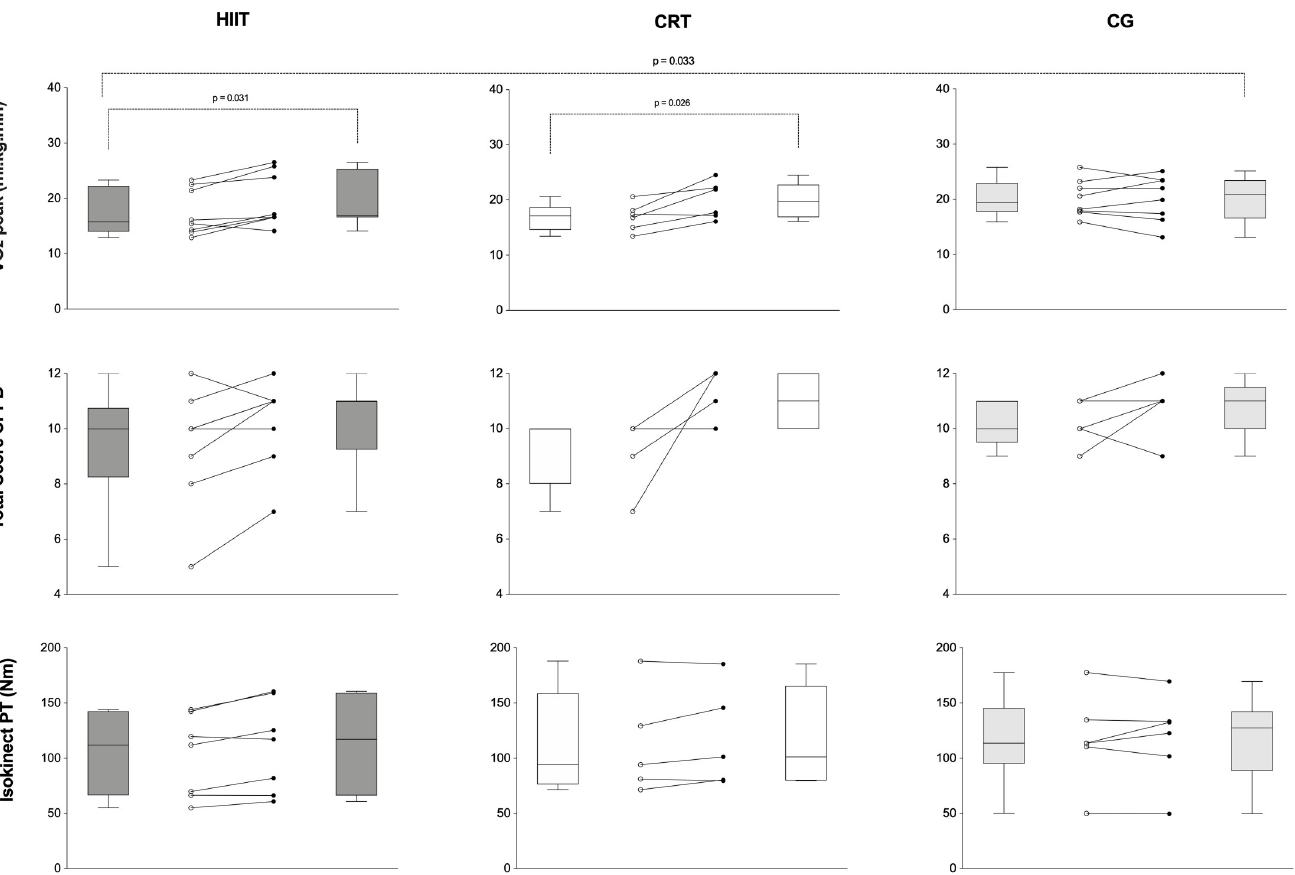
Fig 5. Individuals dynamics per groups. HIIT, high-intensity interval training; CRT, circuit-resistance training; CG, control group; _ V _ O 2 , oxygen uptake; mL/kg/ min, millimeter per kilogram per minute; SPPB, short physic performance battery; PT, peak torque; Nm, newton-meter; p, statistical significance.